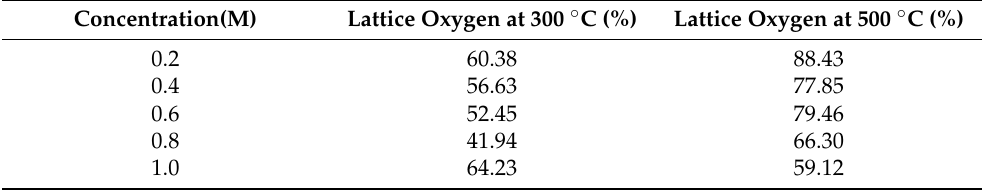
Table 1. The relative proportion of lattice oxygen under different conditions.